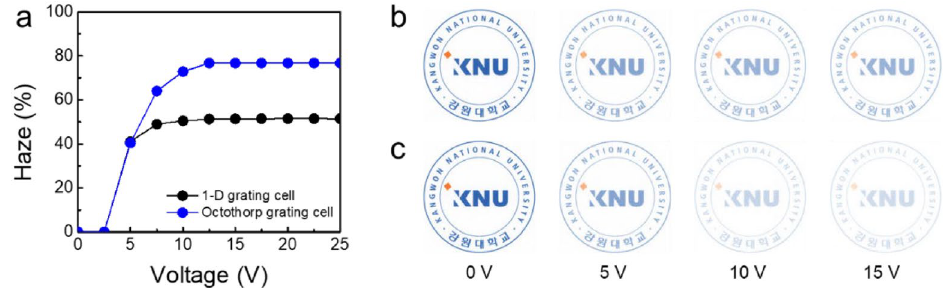
Figure 4. ( a ) Haze values of 1-D grating cell and octothorp grating cell. The calculated images of the ( b ) 1-D grating and ( c ) octothorp grating cells with the KNU logo.